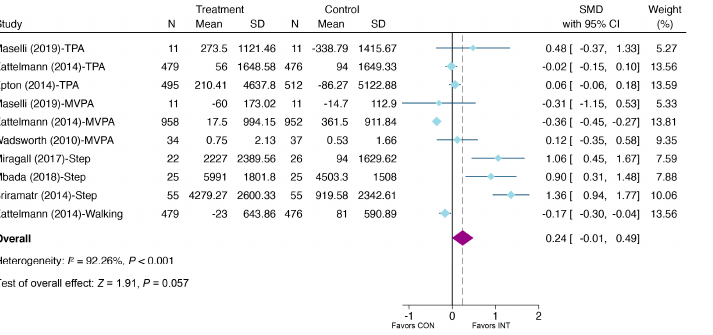
Figure 5. Meta-analysis of effects of e-health interventions on PA at follow-up versus control